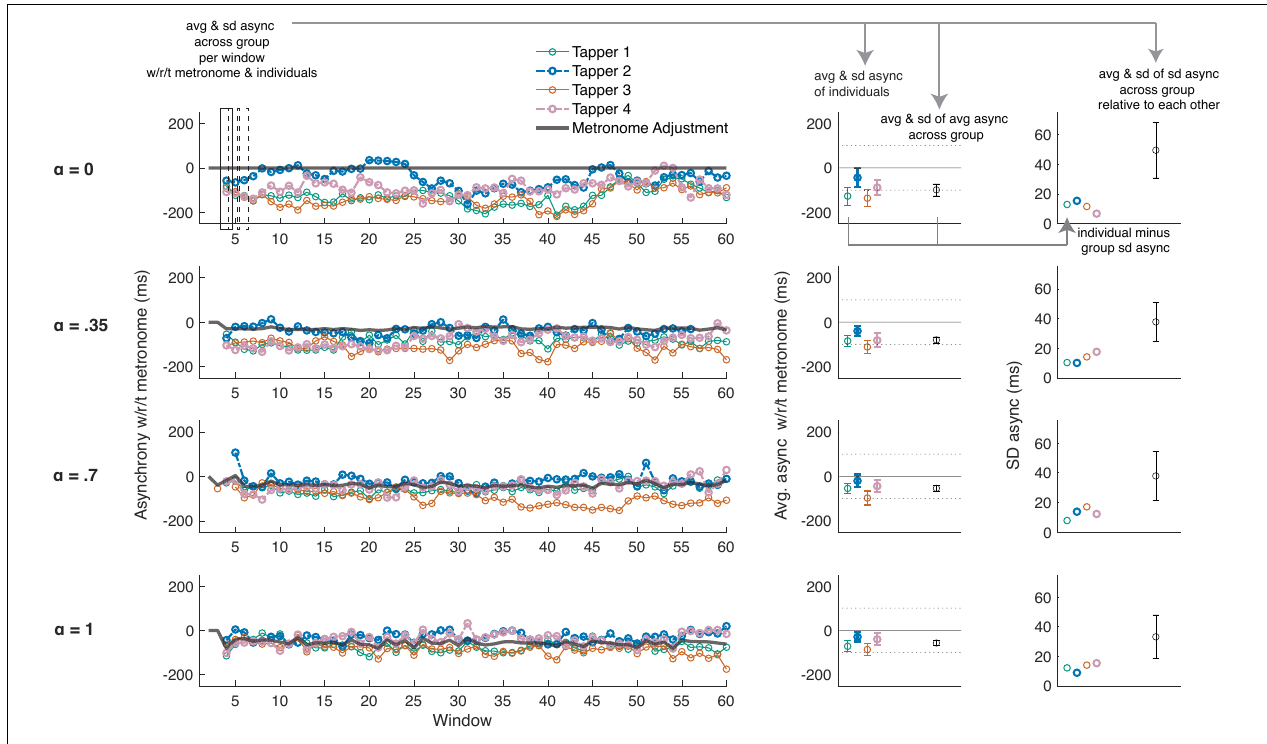
FIGURE 3 | An example run (left panels) at each adaptivity condition (rows) during the group tapping experiments. The metrics illustrated in this figure are applicable to all group tapping experiments, though this particular example comes from Exp. 5 (when all participants could hear each other and the metronome). The individual, colored lines and dots represent the individual tappers in the group. The solid gray line represents the adjustments of the metronome. Note that there are no adjustments in the top left panel when α = 0 (i.e., the control condition that mimics a standard metronome). In the middle panels, the average asynchrony (dots) and SD of the average asynchrony (error bars) of all individuals (colored dots) and the group (black dot), with respect to the metronome, are plotted. A solid line at 0 and dotted lines +/– 100 ms are plotted for reference. The group SD asynchrony (error bars of black dot) was our main metric of interest (see Figure 4 ). In the right-most panels, the colored dots show the difference between each individual’s SD asynchrony and the group SD asynchrony. This metric indexes how variable the individual is vs. the group as a whole, with respect to the metronome, and is used in our models assessing individual differences. The black dot represents the average of the SD asynchrony of the individuals, across all windows; the error bar is the SD of this average SD asynchrony, which we consider an index of how variable individuals’ taps are with respect to each other (rather than the metronome).